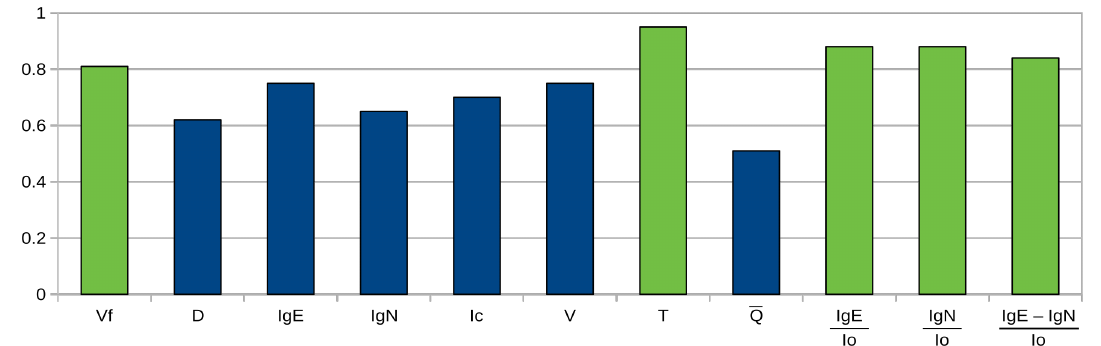
Figure 11. Spearman’s index calculated for the 11 indicators of 1D-2D map similarity for the 17 rainfall-runoff events simulated by SWMM and MIKE models in the Corace torrent (Calabria, Southern